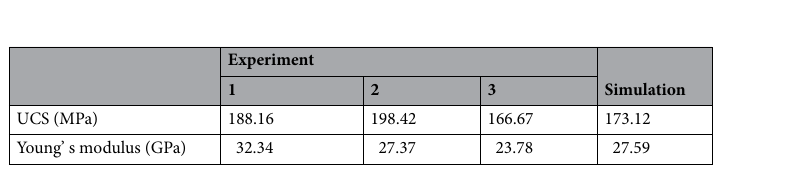
Table 2. Calibrated results of macro properties.